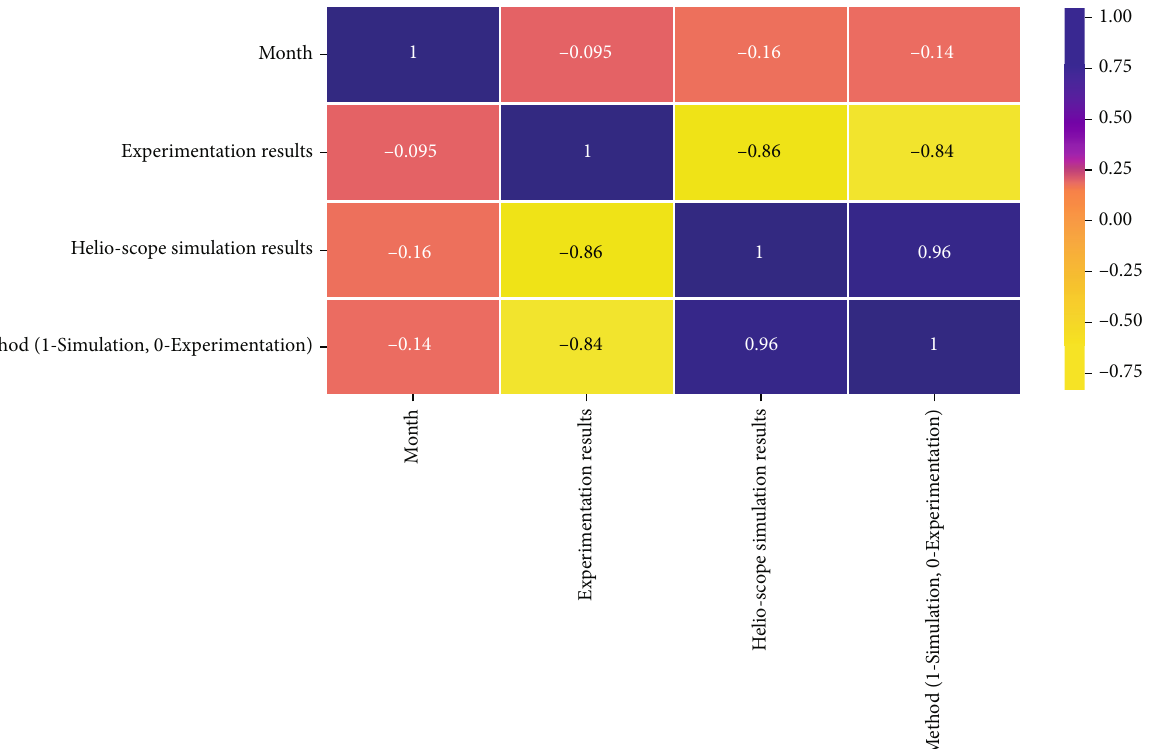
Figure 7: Heat map between each independent and dependent variable in case of monoperk crystalline